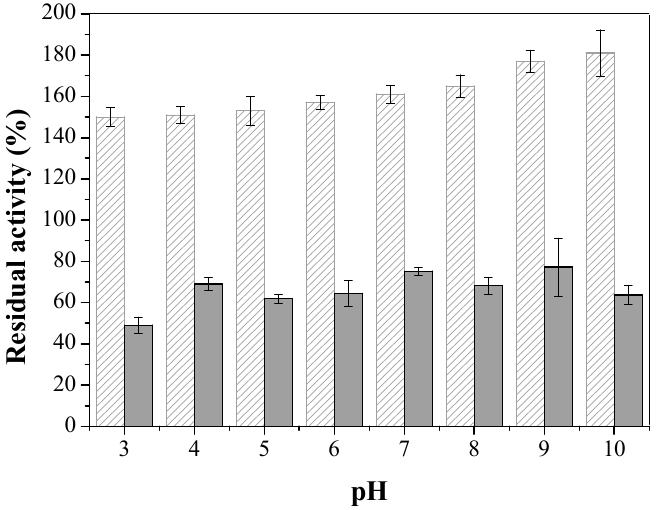
Figure 9. Residual activity (%) related to pH variation for free LU (solid) and immobilized LU (striped) in CTA. The error bars are derived from triplicates.